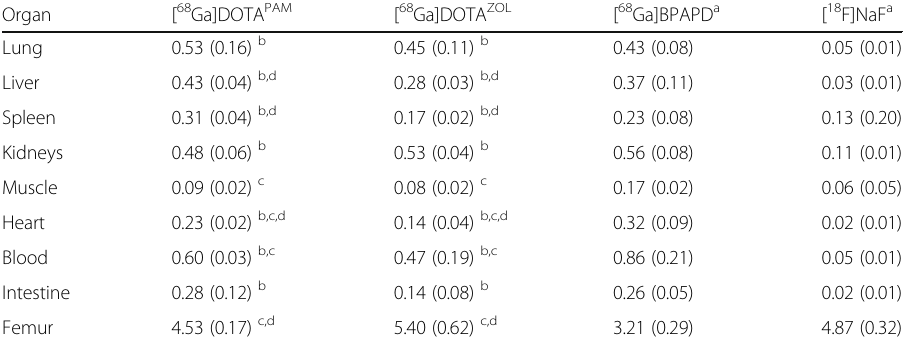
Table 1 Ex vivo biodistribution of [ 68 Ga]DOTA PAM , [ 68 Ga]DOTA ZOL , [ 68 Ga]BPAPD and [ 18 F]NaF in healthy Wistar rats after 60 min p.